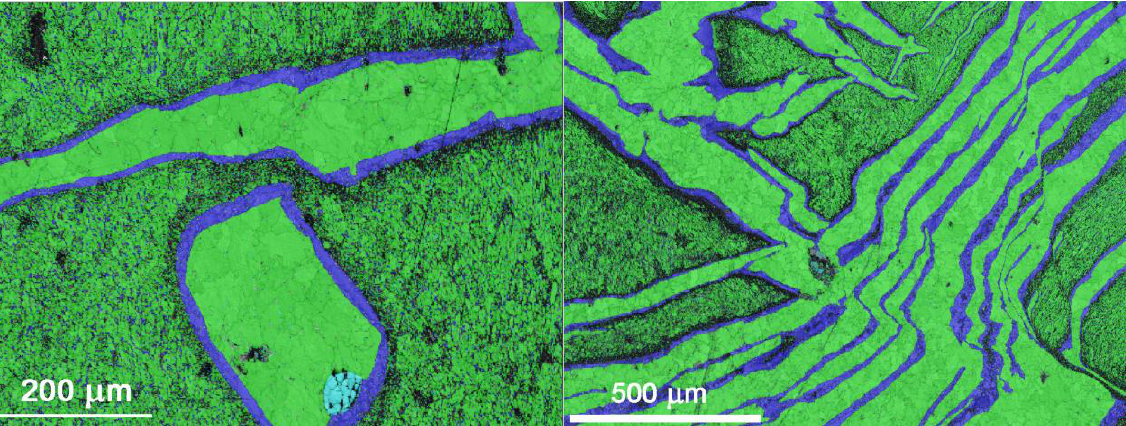
Figure 7. Band contrast and phase maps of two selected areas of a polished sample of the Oglat Sidi Ali meteorite; green is the alpha phase (kamacite); blue is the gamma phase (taenite or Ni-rich taenite); pale blue is the troilite ( left ) and nickel-phosphide ( right ).